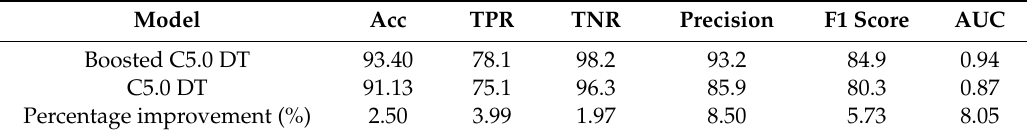
Table 8. Percentage improvement after applying Boosting technique to C5.0